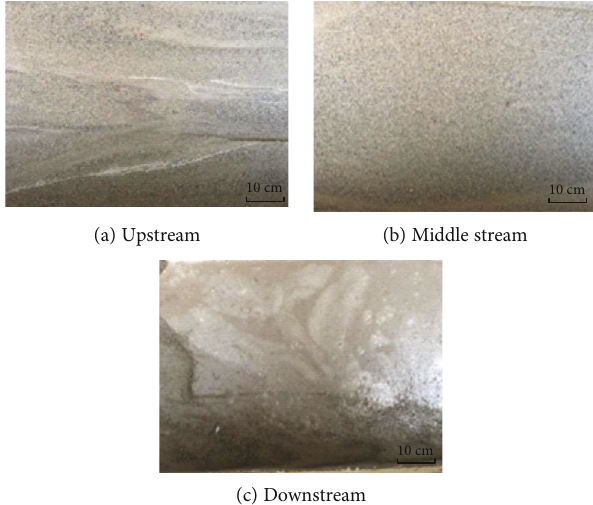
Figure 6: Tail sand discharge experiment